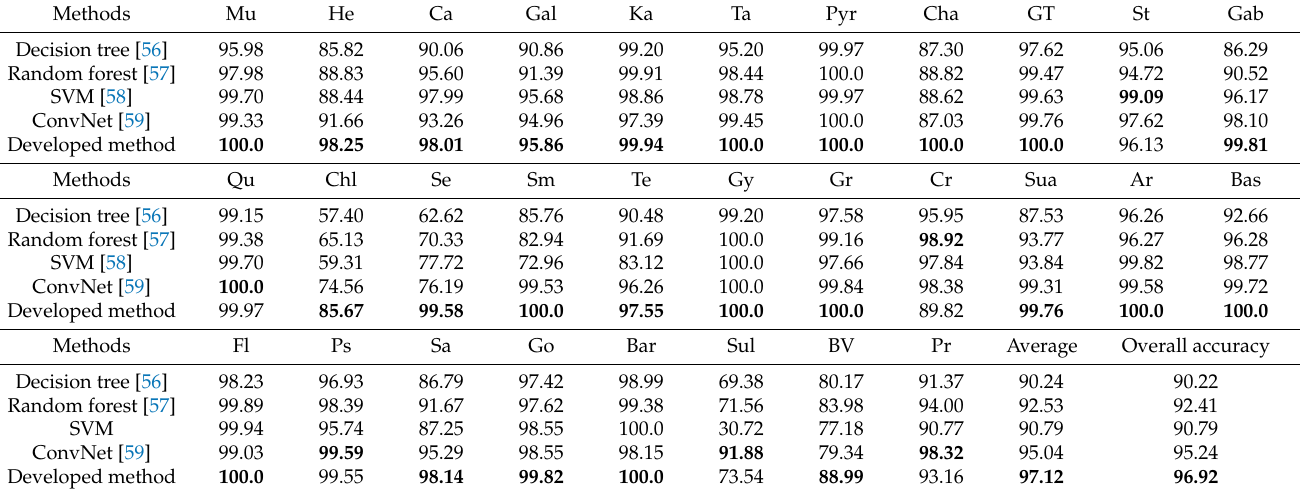
Table 6. Comparisons with other methods in F 1 − score per class and overall accuracy (%). For abbreviation, muscovite (Mu), hematite (He), calcite (Ca), galena (Gal), kaolinite (Ka), talcum (Ta), pyrite (Pyr), chalcopyrite (Cha), gray tiemannite (GT), stibnite (St), gabbro (Gab), quartz (Qu), chlorite (Chl), serpentine (Se), smaltite (Sm), tennantite (Te), gypsum (Gy), graphite (Gr), crystal (Cr), suanite (Sua), aragonite (Ar), basalt (Bas), fluorite (Fl), psilomelane (Ps), saponite (Sa), goethite (Go), barite (Bar), sulfur (Sul), biotite vermiculite (BV), and pyroxenite (Pr). The best performance is highlighted in BOLD